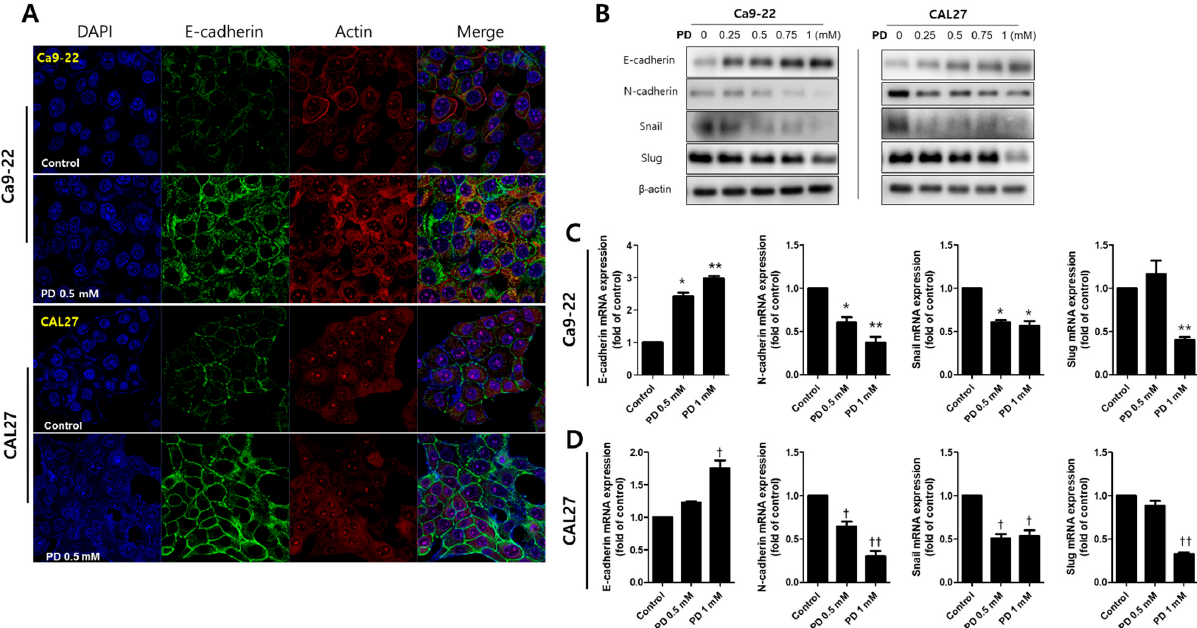
Figure 6. Polydatin-regulated expression of EMT-related proteins and genes in OSCC cells. ( A ) Ca9-22 and CAL27 cells were treated with 0.5 mM polydatin for 24 h, subjected to immunofluorescence assay, and imaged and analyzed by confocal microscopy. The nuclei, E-cadherin, and actin were stained with DAPI (blue), Alexa 488 (green), and rhodamine phalloidin (red), respectively. ( B ) Ca9-22 and CAL27 cells were treated with 0–1 mM polydatin, and their expression levels of autophagy-related proteins, namely, E-cadherin, N-cadherin, Snail, and Slug, were determined. β -actin protein was used as internal control. ( C ) Ca9-22 and ( D ) CAL27 cells were treated with 0, 0.5, and 1 mM polydatin for 24 h, and the gene expression levels of E-cadherin, N-cadherin, Snail, and Slug were determined through QPCR. Results are expressed as mean ± SD. Data were derived from three independent experiments. (Ca9-22: * p < 0.05, ** p < 0.01; CAL27: † p < 0.05, †† p <